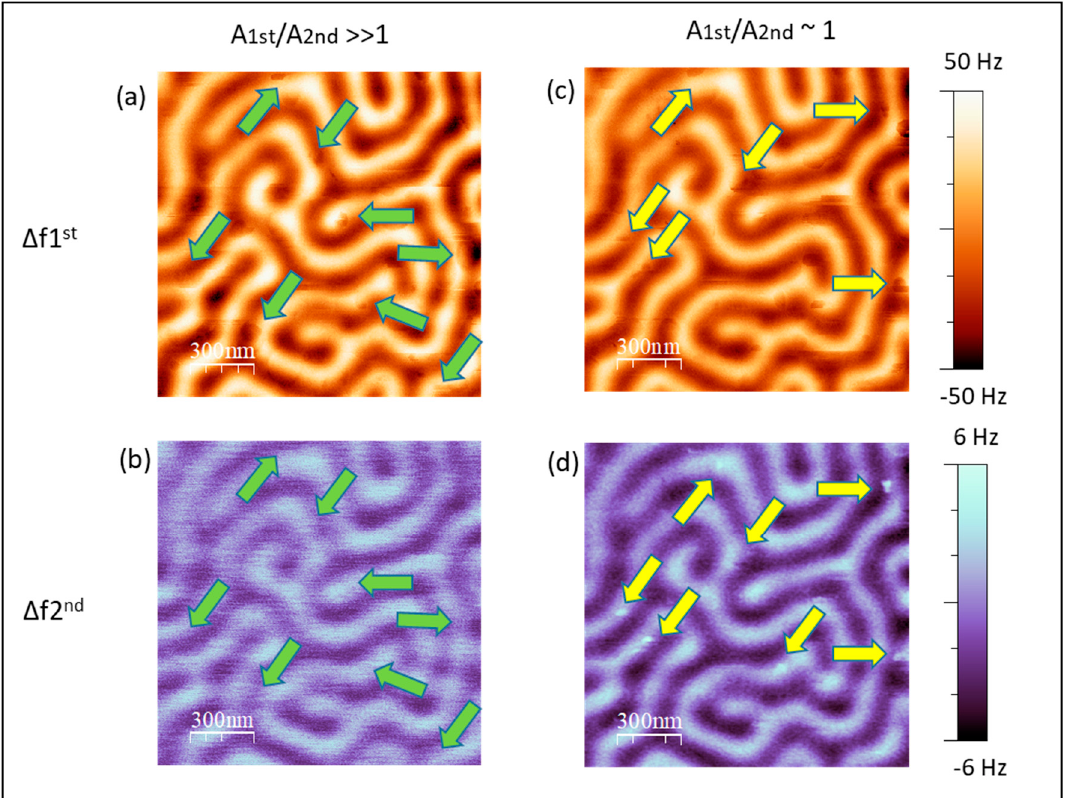
Figure 3. Different A 1 /A 2 .ratio Left panel corresponds to a typical Bimodal MDFM experiment where the amplitude of the first mode is much higher than the amplitude of the second mode. Right panel corresponds to another set of measurements where the amplitude of both modes is similar. A PLL is enabled in all cases. ( a , b ) are the frequency shift channels of the first and the second mode at a retrace distance of 10 nm. ( c , d ) are the frequency shift channels of the first and the second mode at a retrace distance of 10 nm when the A 1 /A 2 ratio is nearly 1. In that case the dissipation-related features (yellow arrows) appear at both channels whereas if the typical ratio between amplitudes is used (A 1 /A 2 >> 1) these features only appear in the magnetic image obtained with the first mode (green arrows). The sample is a FePd thin film. Images size: 1.5 μ m × 1.5 μ m.